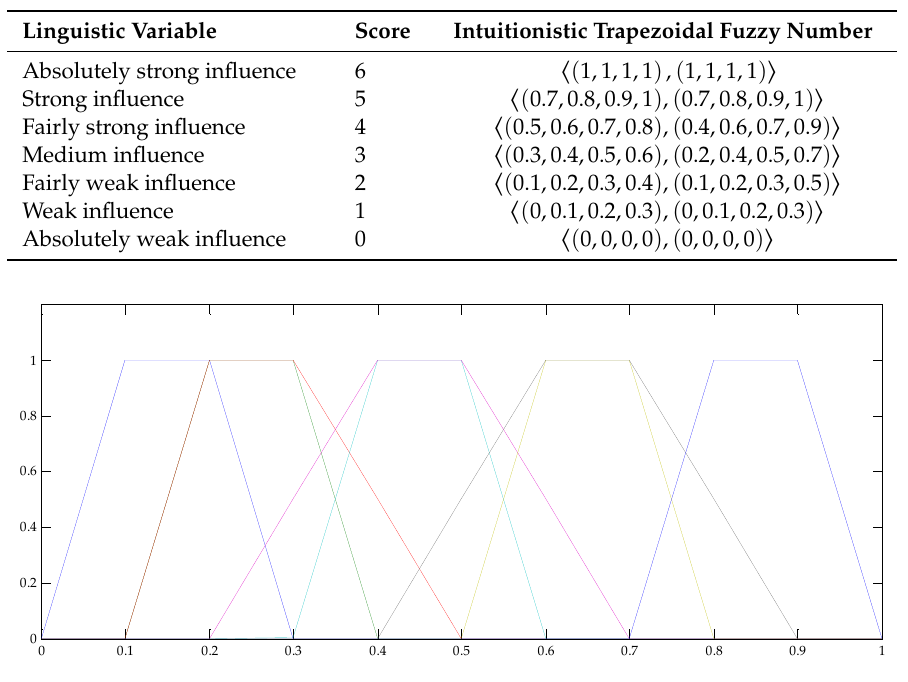
Figure 2. The membership and non-membership function of trapezoidal IFN for the degree of influence.